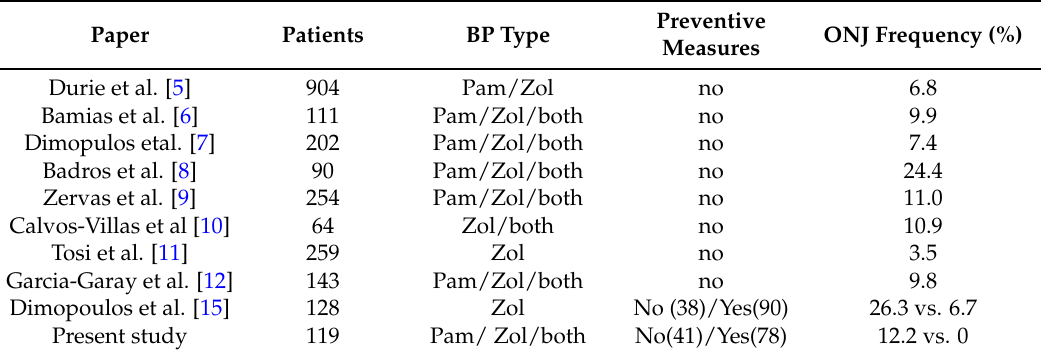
Table 3. Incidence of BP-related ONJ in MM